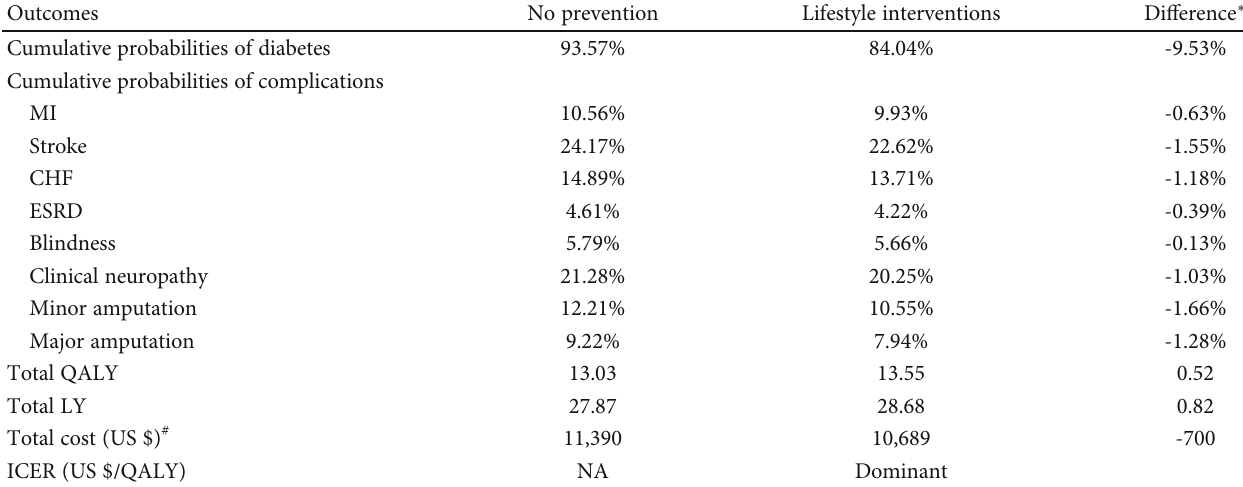
Table 2: Base case results for lifestyle interventions compared to no prevention.